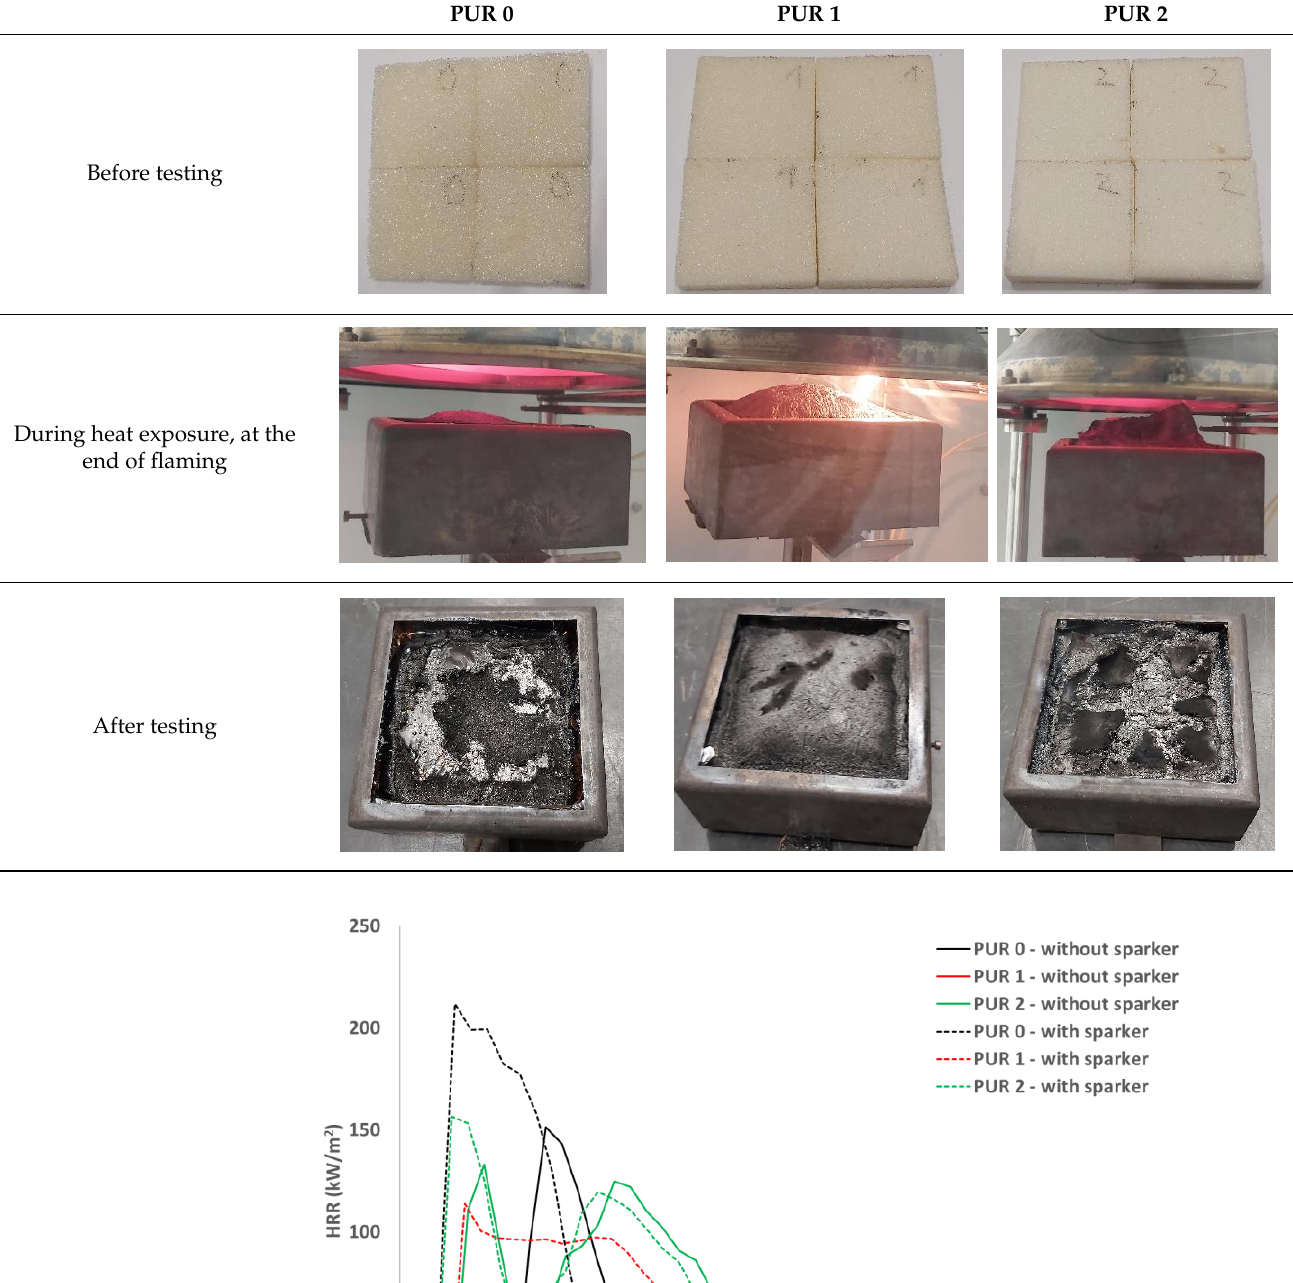
Table 6. Ignition times and flame duration for the three PURs exposed to 40 kW/m 2 of heat flux self-ignited or ignited with a spark igniter.